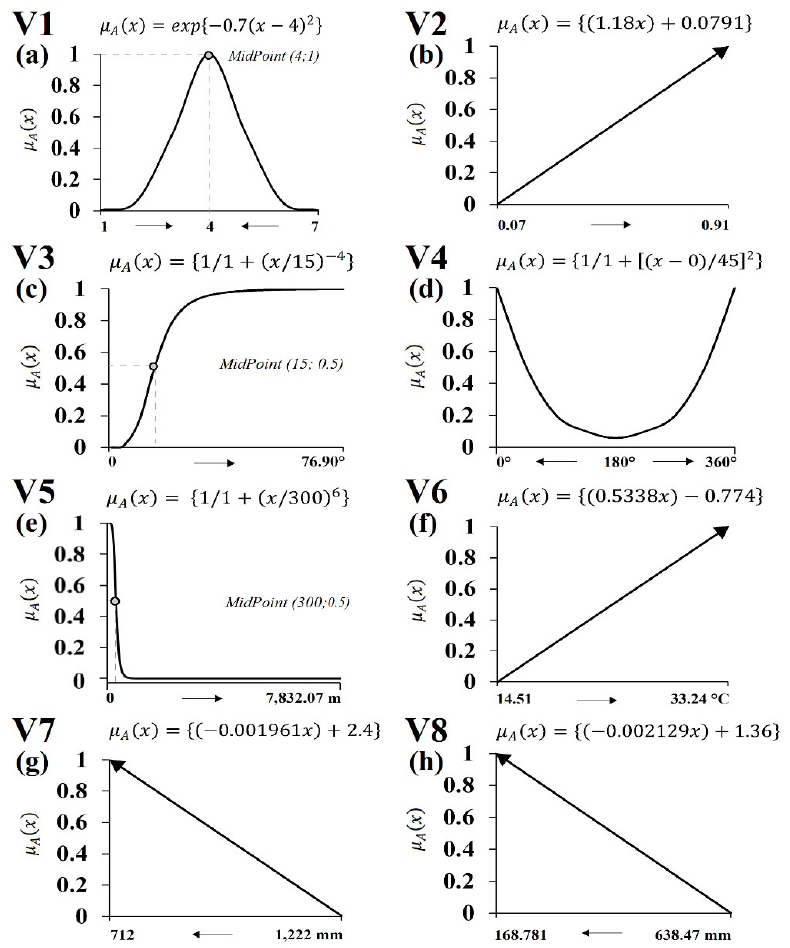
Fig. 3. Fuzzy membership function diagrams. (a) V1 – Land use – Fuzzy Gaussian; (b) V2 – NDVI – Fuzzy Linear; (c) V3 – Slope (º) – Fuzzy Large; (d) V4 – Aspect (º) – Fuzzy Generalized Bell; (e) V5 – Proximity to roads (m) – Fuzzy Small; (f) V6 – Temperature (ºC) – Fuzzy Linear; (g) V7 – Rainfall (mm) – Fuzzy Linear; (h) V8 – water availability (mm)